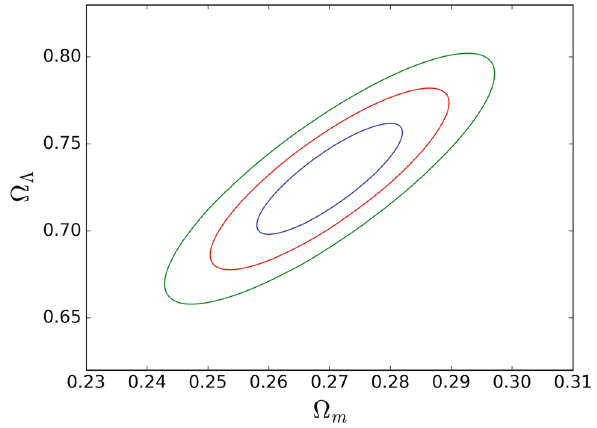
Fig. 11 Same as Fig. 10, but for 38 actual OHD sets. The FoM here is 9.3